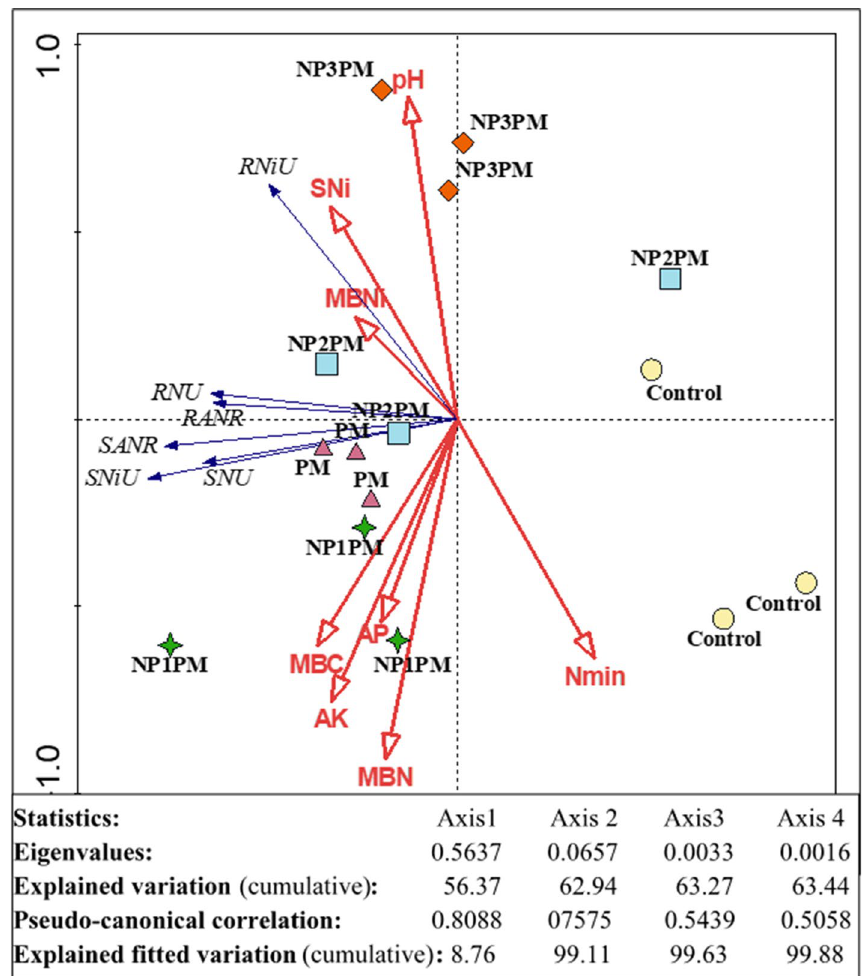
Figure 6. Redundancy analysis (RDA) of soil pH, mineral N (Nmin), nickel (SNi), available P (AP) and K (AK), microbial biomass carbon (MBC), nitrogen (MBN), nickel (MBNi), shoot nitrogen uptake (SNU), Ni uptake (SNiU), apparent N recovery (SANR), root nitrogen uptake (RNU), apparent N recovery (RANR) and Ni uptake (RNU) from control, poultry manure (PM), low dose NiONPs (NP1), intermediate (NP2) and high (NP3) amended PM. Treatments are signified as circle (Control), triangles (PM), stars (NP1PM), squares (NP2PM) and diamond (NP3PM). PC1 (56.3%) and PC2 (62.9%) explained most of the variations in the data with unit less individual